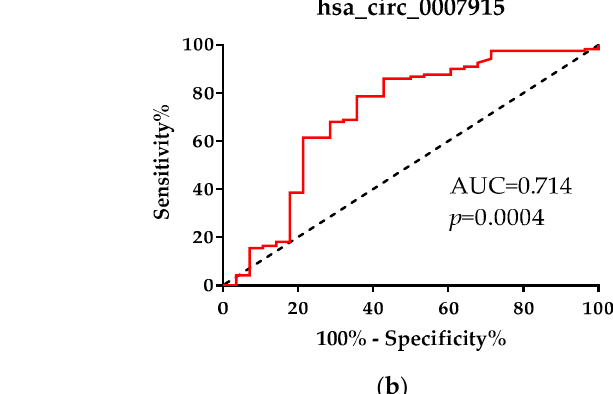
( c ) ( d ) Figure 3. ( a ) Differential gene expression of hsa_circ_0001445 ( SMARCA5 ) in malignant cells and immune and stromal sells; ( b ) Detailed presentation of expression levels of SMARCA5 gene in TME; ( c ) Differential gene expression of hsa_circ_0007915 ( IPO11 ) in malignant cells and immune and stromal cells; ( d ) Detailed presentation of expression levels of IPO11 gene in TME. Visualizations were generated using TISCH database including single-cell transcriptome profiles [37]. 2.5. Low hsa_circ_0001445 Levels in Plasma Are Associated with Short Survival We have found that of all investigated circRNAs only hsa_circ_0001445 had a prog- nostic significance (Figure 4). Patients were divided into three groups according to their expression levels of hsa_circ_0001445-with low (up to the 33rd percentile, range: 0.13– 1.20), with intermediate (between the 33rd and 66th percentiles, range: 1.21–2.21), and with high expression (over the 66th percentile, range: 2.22–6.86). In the group of CRC pa- tients in stage IV, those with low expression of hsa_circ_0001445 had a mean overall sur- vival of 20 months (95% CI: 16.70–23.76), those with high expression of hsa_circ_0001445 had a mean overall survival of 26 months (95% CI: 20.23–32.59), and the patients with intermediate expression of hsa_circ_0001445 had a mean overall survival of 33 months